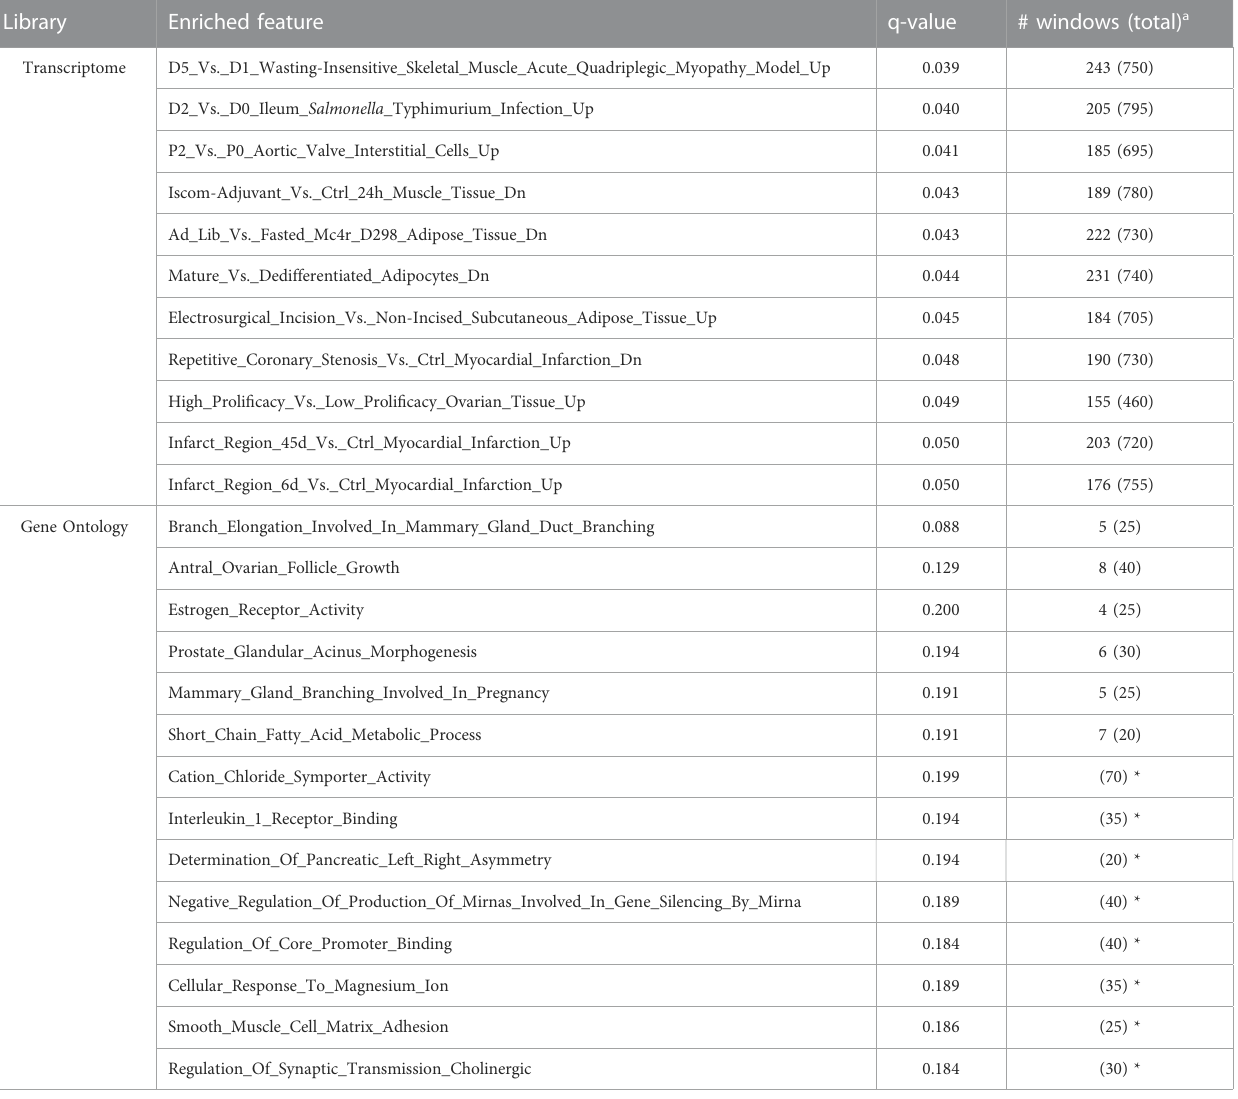
TABLE 3 Features that were signi fi cantly (q-value ≤ 0.05 for Porcine Transcriptome library and ≤ 0.2 for GO library) enriched in the ranked gene set enrichment analysis based on two customized libraries and the number of 1 Mb windows that contributed to the core.